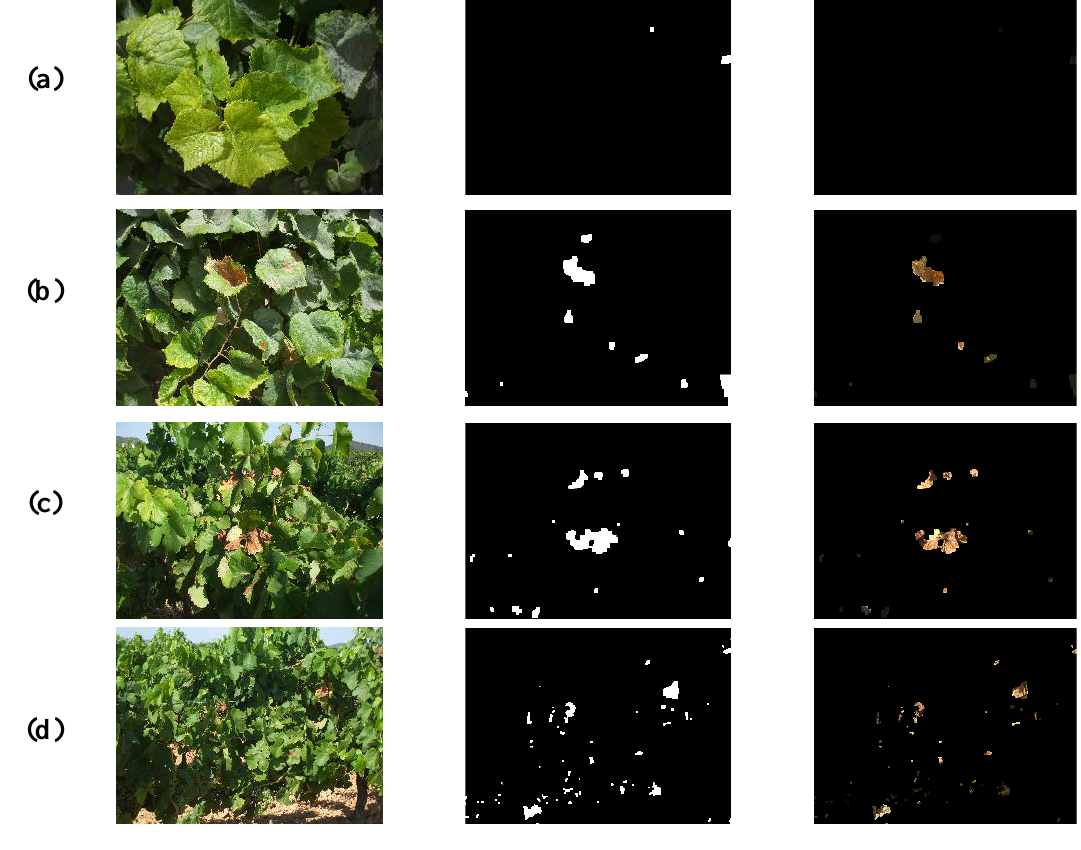
Figure 17. Four examples of detections in images taken from different distances. In each case, we show the original image in the first column, the final detection mask obtained in the second, and the masked image in the third. (a) An example of an image with